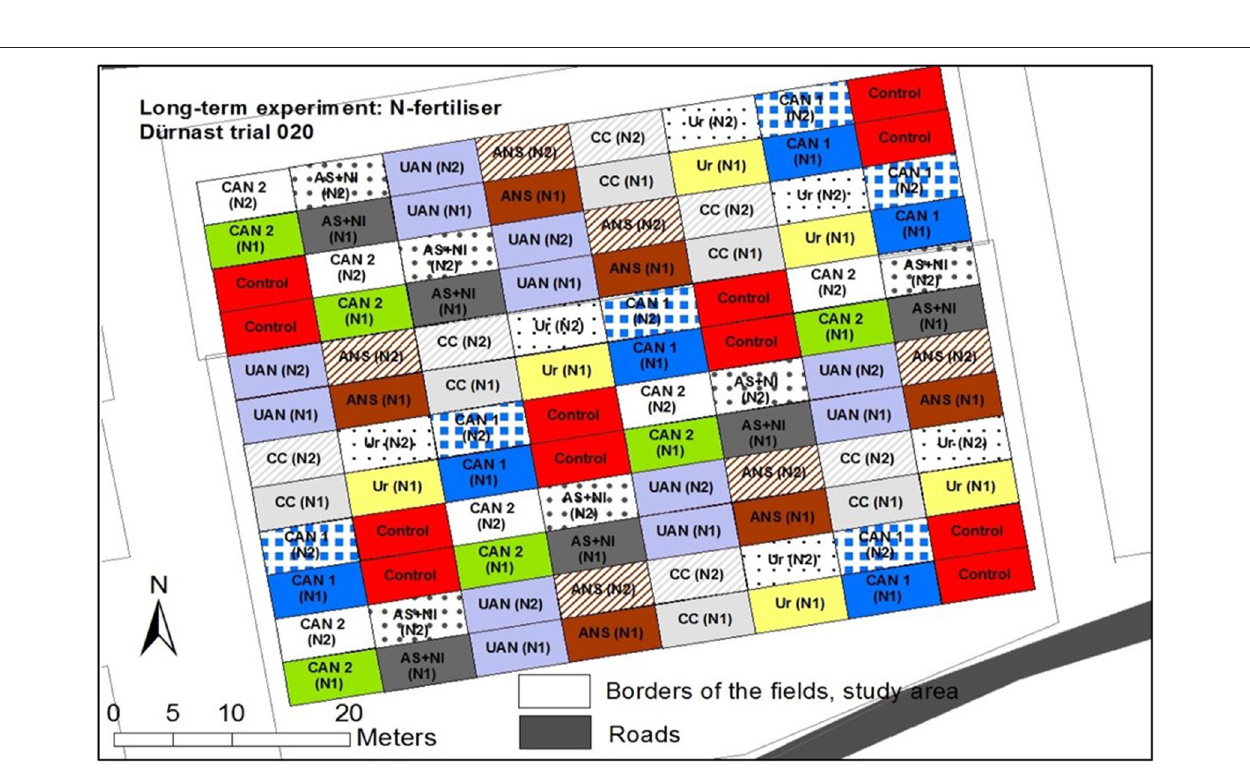
Frontiers in Environmental Science | www.frontiersin.org